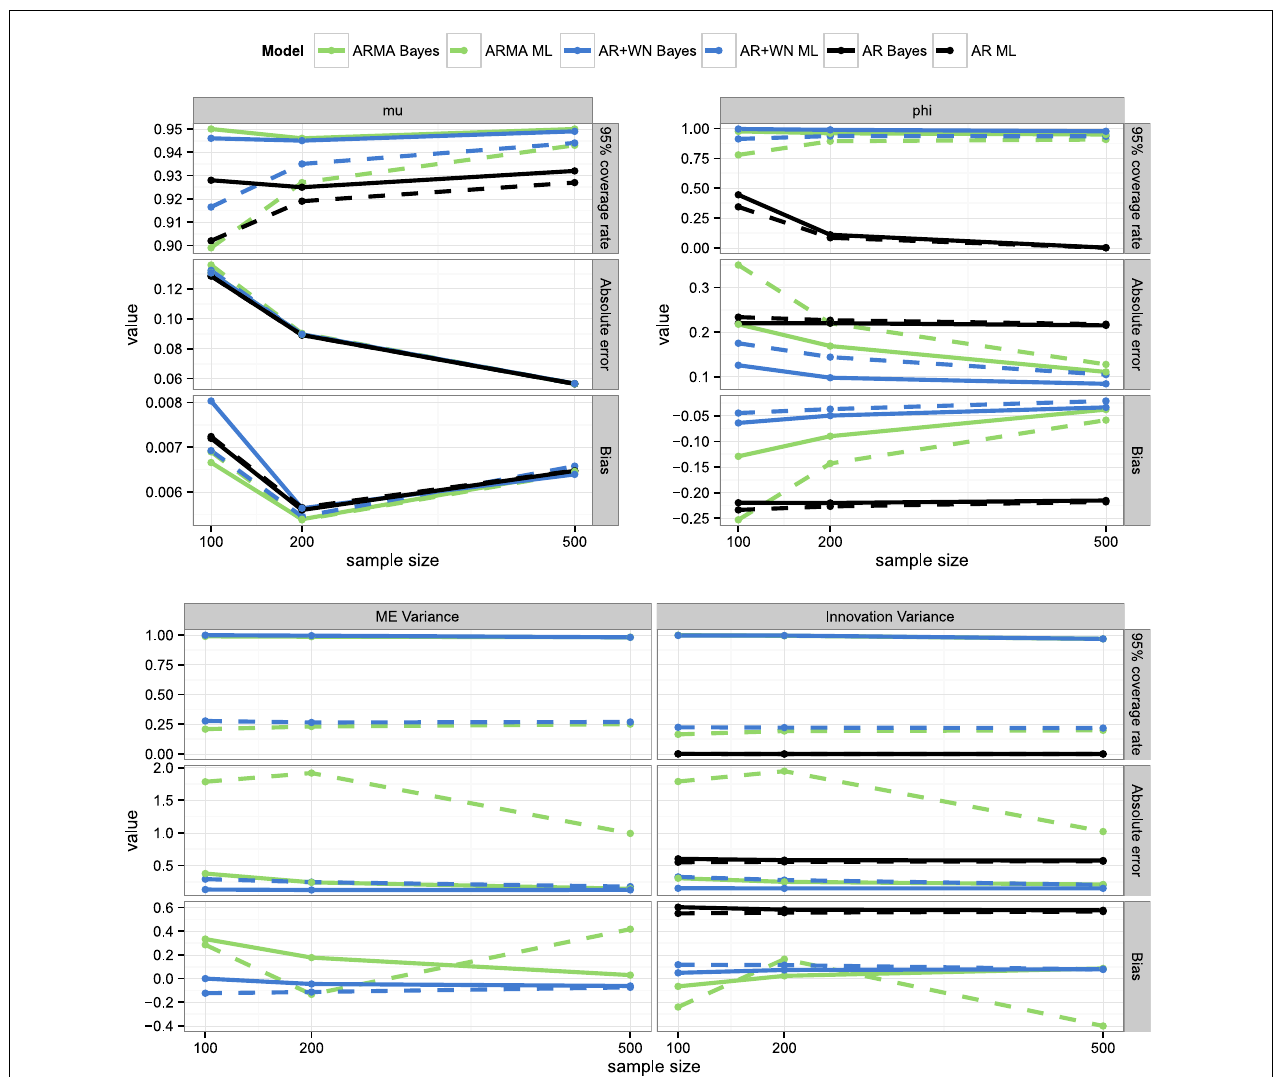
FIGURE 4 | Coverage rates, absolute errors, and bias for the parameter estimates for the frequentist and Bayesian AR(1), ARMA(1,1), and AR(1) + WN models across sample